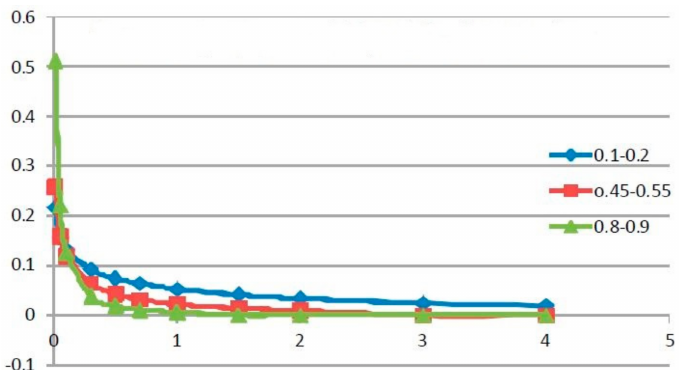
Figure 2. The time domain expression of the pseudo-Green function or kernel h ( t ) is shown graphically in the figure, with c = 0.8; d = 0.9; with c = 0.45; d = 0.55 and with c = 0.1; d =